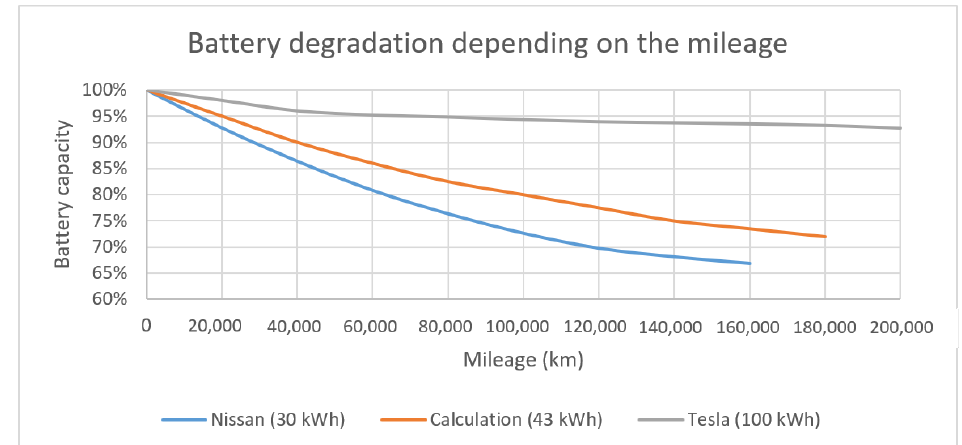
Figure 3. Battery degradation depending on mileage [20,21].